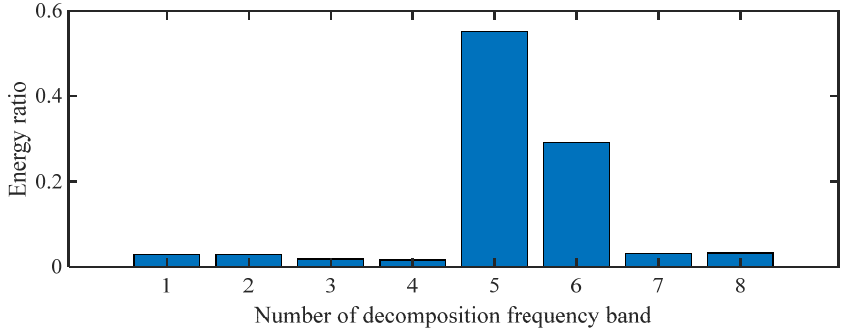
Figure 14. Energy distribution proportional histogram of the vibration signal.